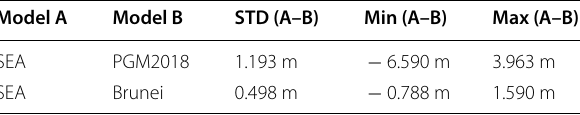
Table 5 Statistics on the residuals of the comparison of SEA regional geoid model with respect to PGM2018 and Brunei local geoid